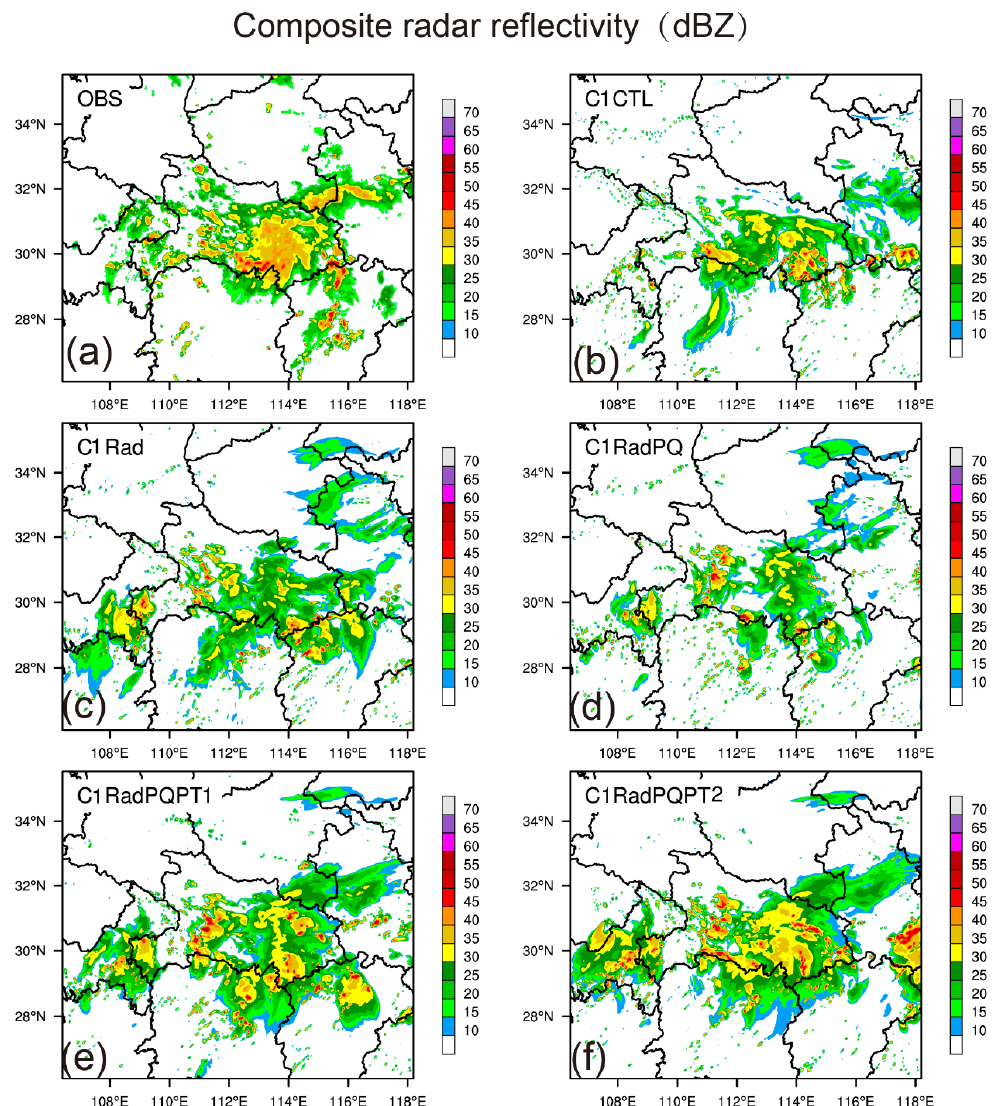
Figure 7. Same as in Figure 6, but for 3-h forecasted composite radar reflectivity (dBZ) launched at 0300 UTC; 30 June, 2018.